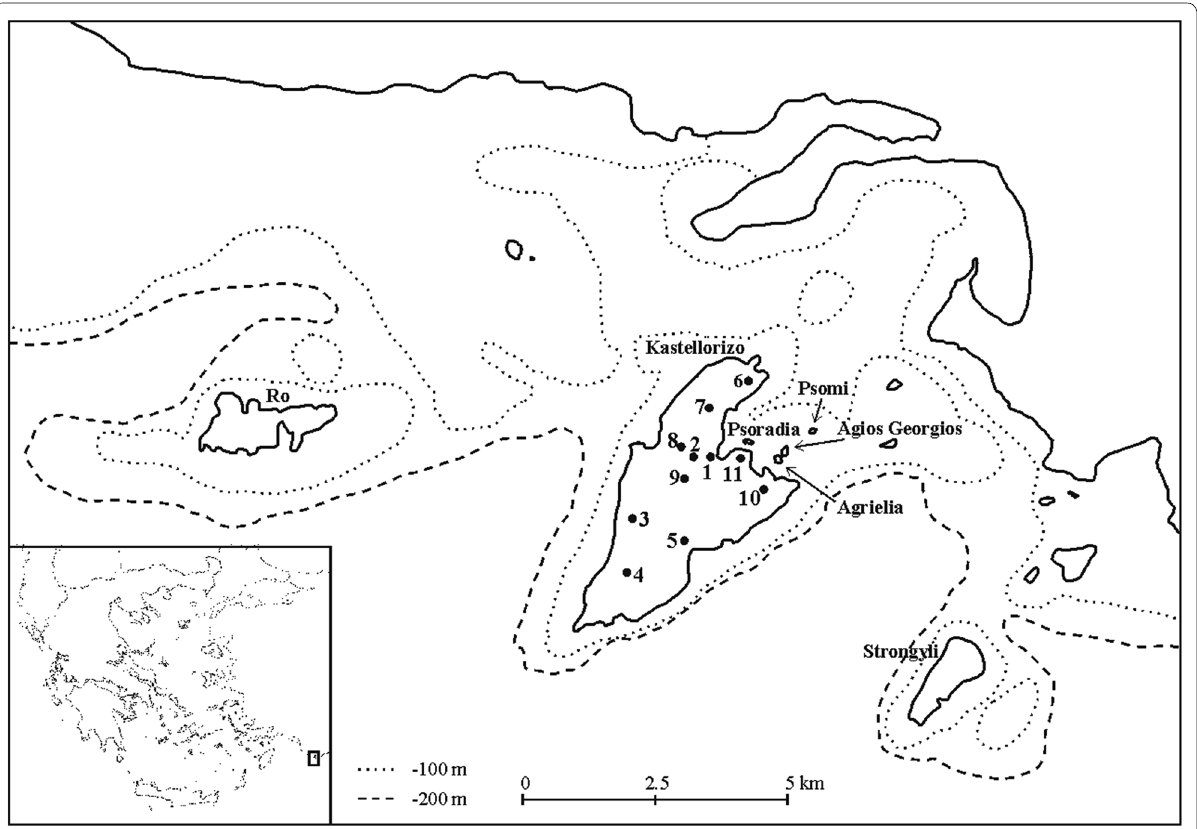
Fig. 1 The studied islets and the sampling sites on